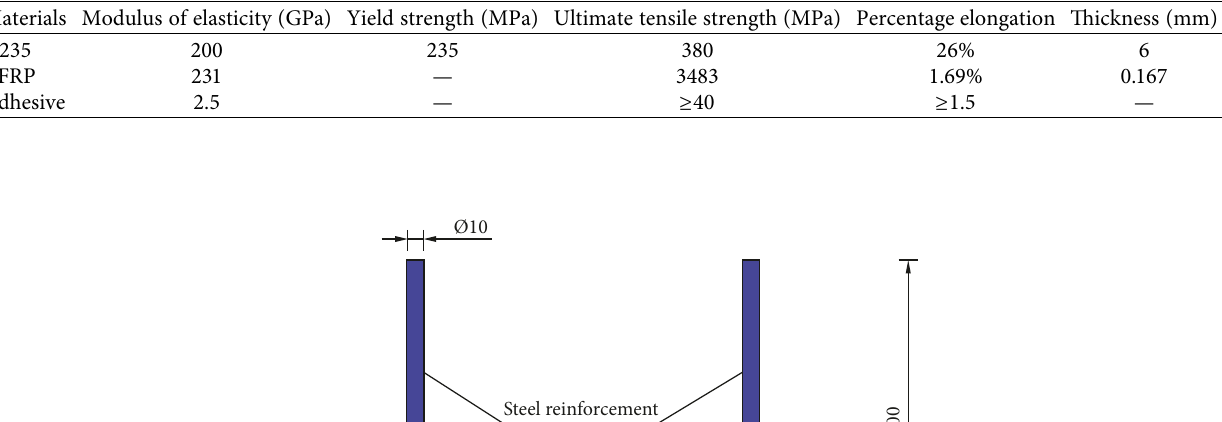
Table 1: Mechanical properties of materials [27].